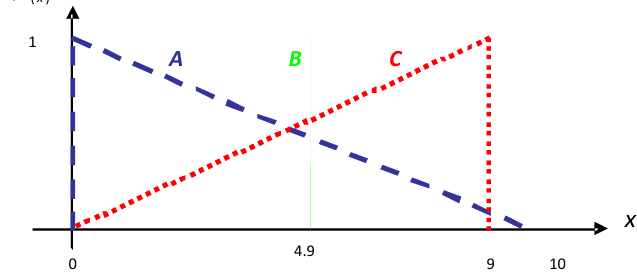
Fig. 1. Comparison of fuzzy numbers A=(0,0,10), B=(4.9,4.9,4.9) and